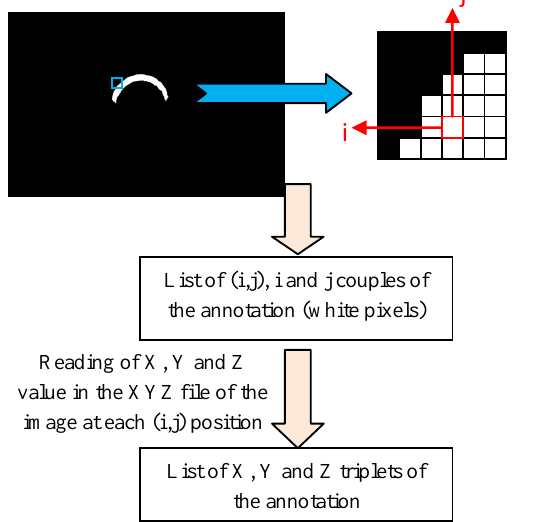
Figure 11: Research of true position and false position on